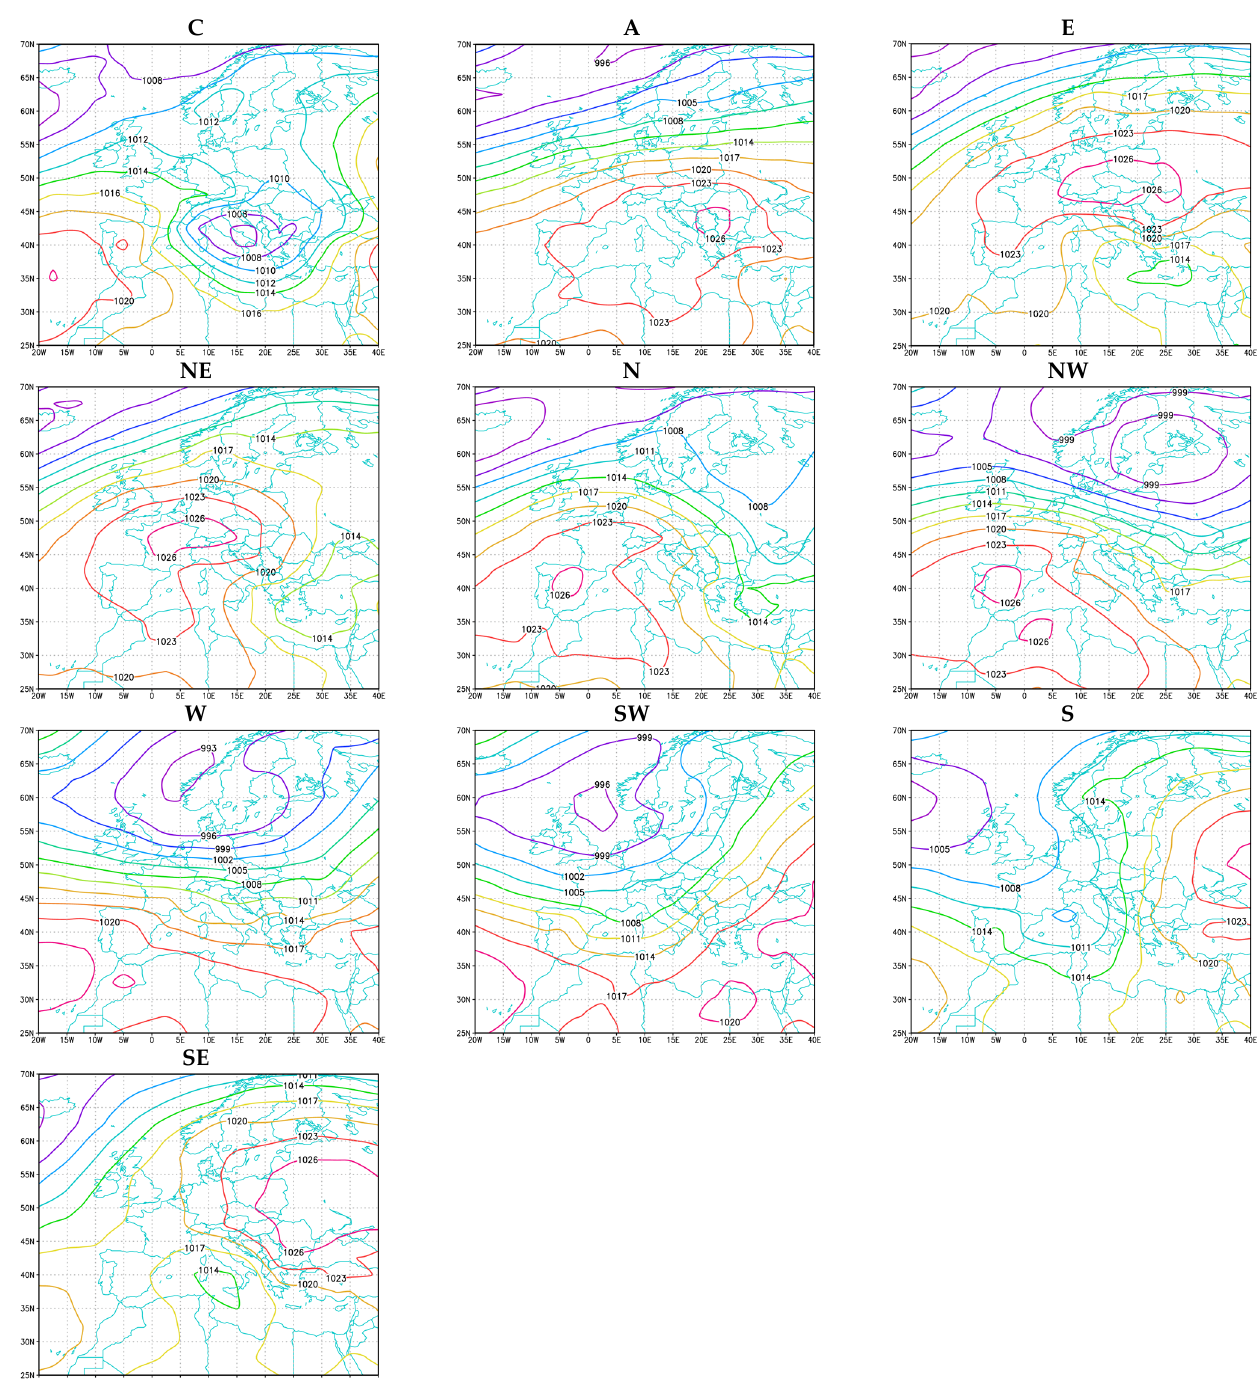
Figure 2. Circulation weather types for winter during the period 1949–2018: C—cyclonic; A—anticyclonic; E—eastern, NE—northeastern, N—northern, NW—northwestern, W—western, SW—southwestern, S—southern and SE—southeastern.